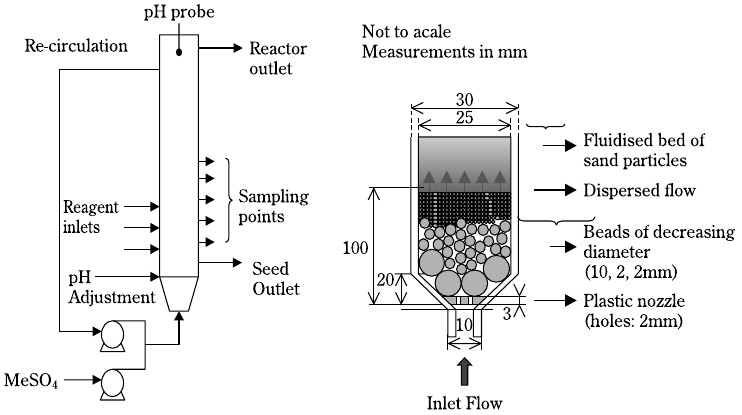
Fig. 1 Schematic representation of the seeded fluidised bed